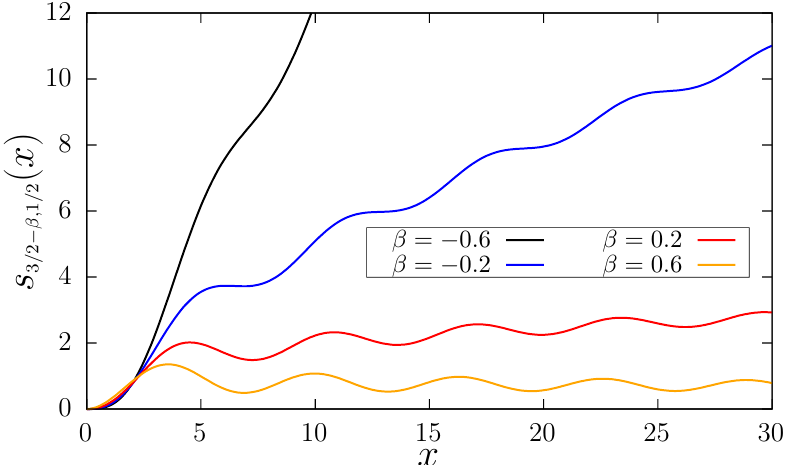
Figure A1. Lommel functions of the form s 3/2 β ,1/2 ( x ) for several values of exponent β . − The Lommel function s µ , ν ( z ) is also related to the generalized hypergeometric